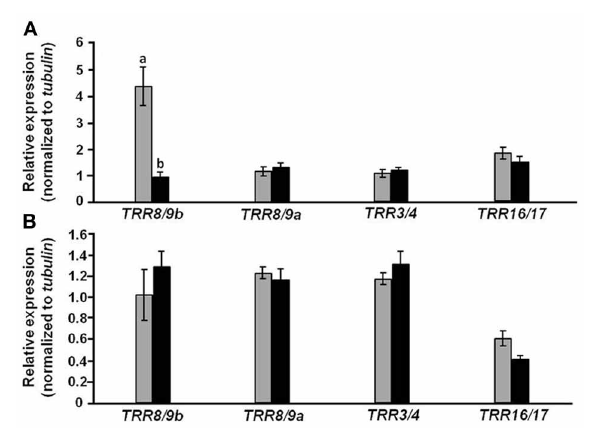
FIGURE 9 | Effect of CmF-308 expression in the phloem of tomato plants on the expression of cytokinin-response genes. The expression of members of the tomato response regulator ( TRR ) gene family was determined by qRT-PCR in leaves (A) and roots (B) of 21-day-old CmF-308 -transgenic (gray columns) and control M-82 (black columns) plants. Data represent means of four replications ± SE. Different letters indicate significant differences in relative expression of specific genes between the two plant lines at p < 0 . 05 by Student’s t